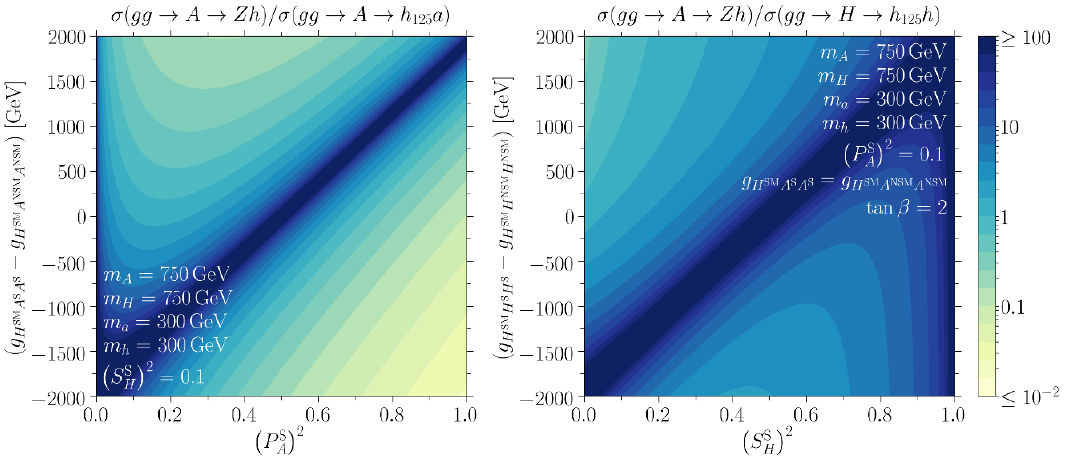
Figure 2 . Same as (cid:12)gure 1 but in the plane of the singlet component of the heavy CP-odd (CP- even) Higgs boson A ( H ) for the left (right) panel and the combination of the trilinear couplings